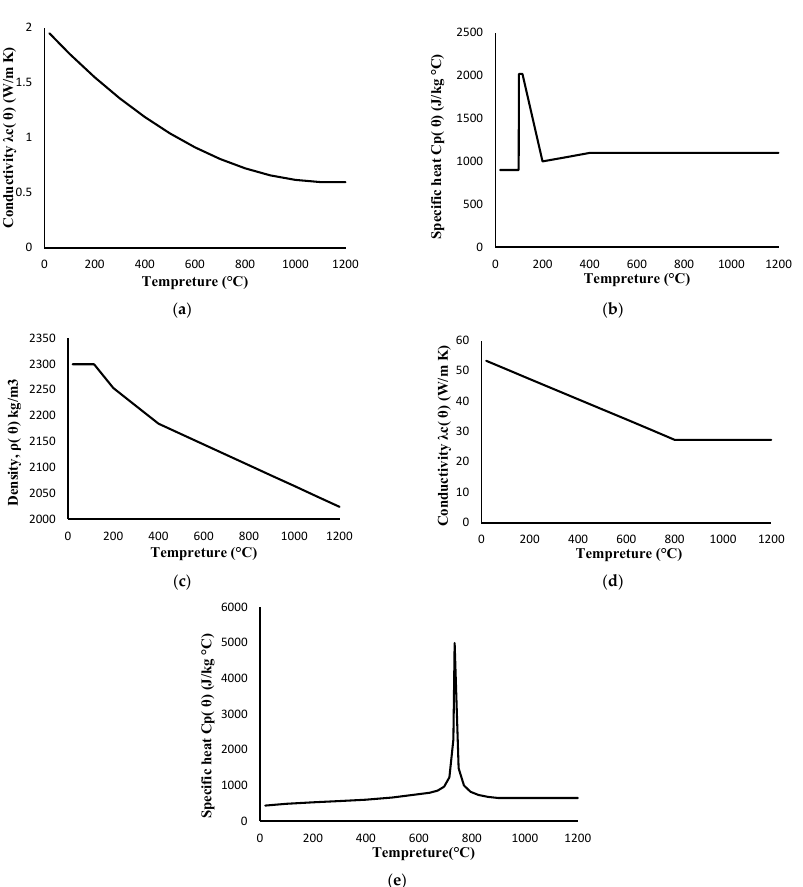
Figure 4. Thermal properties versus temperature: ( a ) Thermal conductivity (upper limit) of concrete, ( b ) Specific heat of concrete, ( c ) Density of concrete, ( d ) Steel conductivity, and ( e ) Specific heat of steel [26].